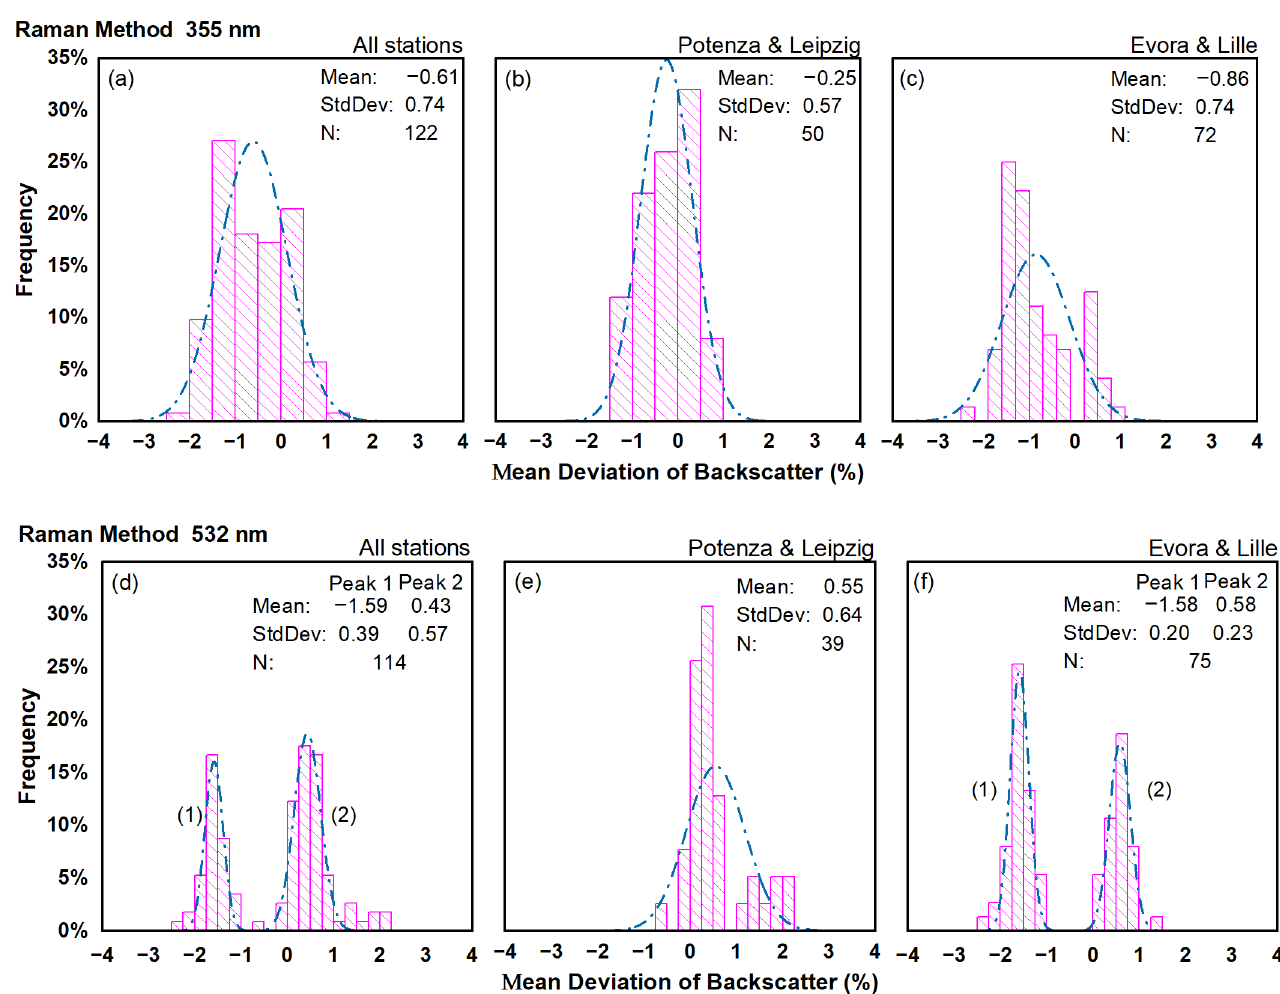
Figure 11. The frequency distributions of the mean relative deviation of Raman backscatter from all the cases at 355 nm and 532 nm ( a , d ), together with IFS_ECMWF vs. ERA5 (for Potenza and Leipzig stations) at two wavelengths ( b , e ) and GDAS vs. ERA5 (for Evora and Lille stations) at 355 and 532 nm ( c , f ). The dotted line shown in the subfigure is the Gaussian fitting curve. Table 6 shows the mean value of the mean relative deviation of the Raman backscat- ter and the mean relative deviation of molecular number density and mean aerosol load. Table 6. The mean value of the mean relative deviation of the backscatter and mean relative devia- tion of molecular number density and mean aerosol load at two wavelengths. The backscatter was obtained by the Raman method. Lidar Name